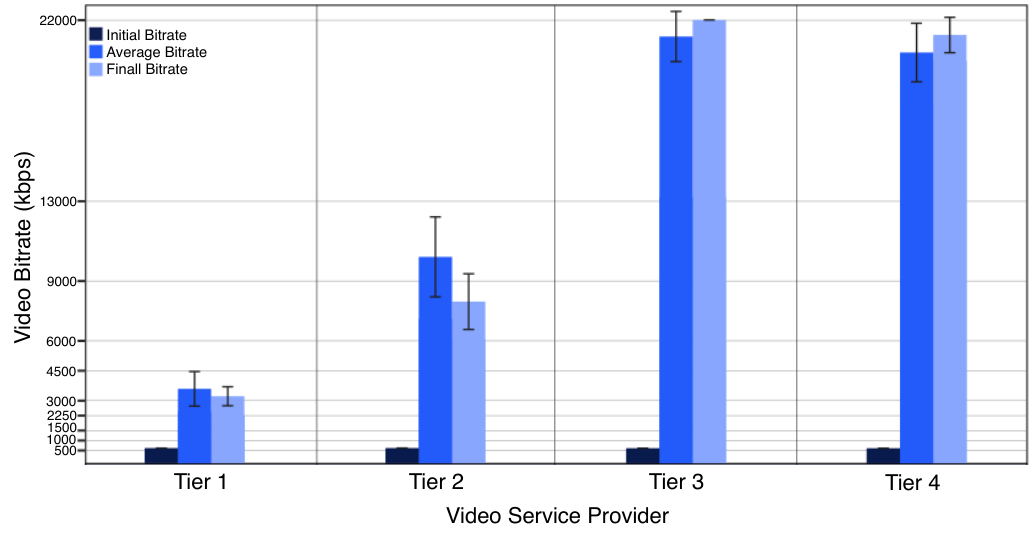
Figure 4. Impact of ABR Schemes Deployed at Different Tiers of the Proposed